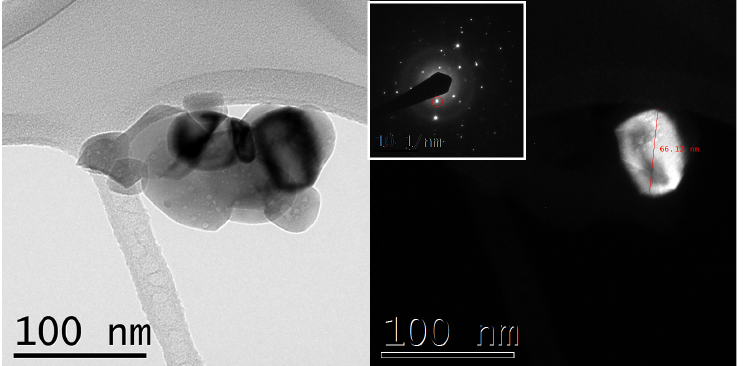
Figure 6. TEM bright-field image of a 10Cu–oxide nanoparticle aggregate and the dark field image of an isolated single crystal nanoparticle and the corresponding electro diffraction